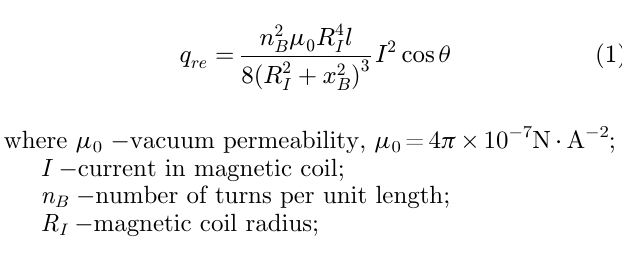
Figure 2. In electromagnetic fi eld, distributed electromag- netic force occurs on the fl exible ring. q re is electromagnetic force per unit length. Meanwhile, molecule force occurs at (cid:1) (cid:3) : q ; p the angle range (cid:1) p r 3 . is Van der Waals force per unit 4 4 length.